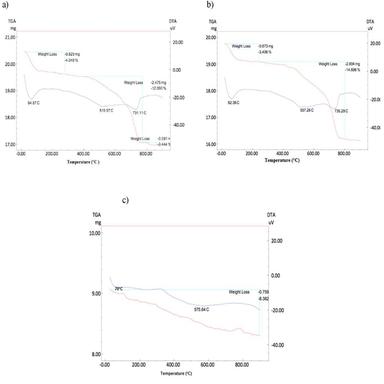
TGA/TDA curves of all samples: a) EB. b) BM. c) BS.